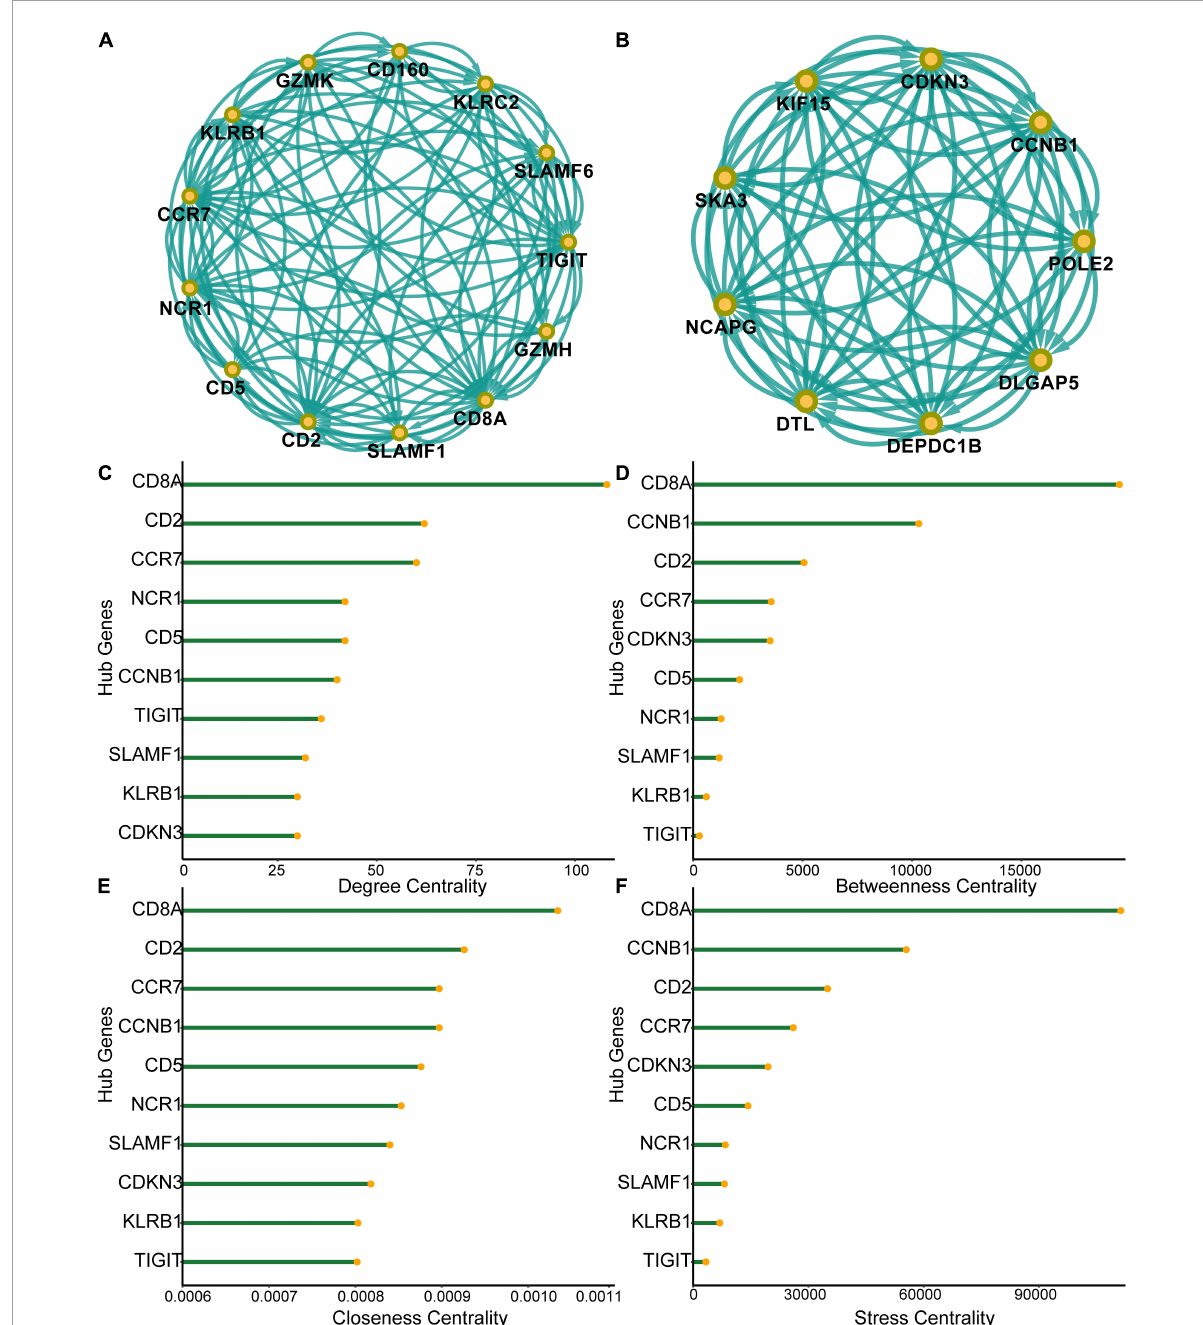
FIGURE3 Protein-protein interaction (PPI) network of differentially expressed genes. (A) Subnetworks of the top-ranked PPI network. (B) Subnetworks of the second-ranked PPI network. (C–F) Analysis of degree centrality, betweenness centrality, closeness centrality and stress centrality in the top two PPI network